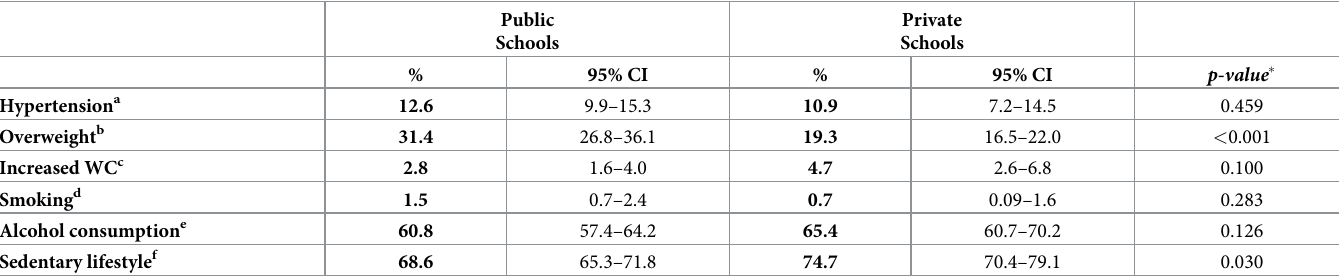
Table 3. Prevalence of modifiable risk factors by public and private